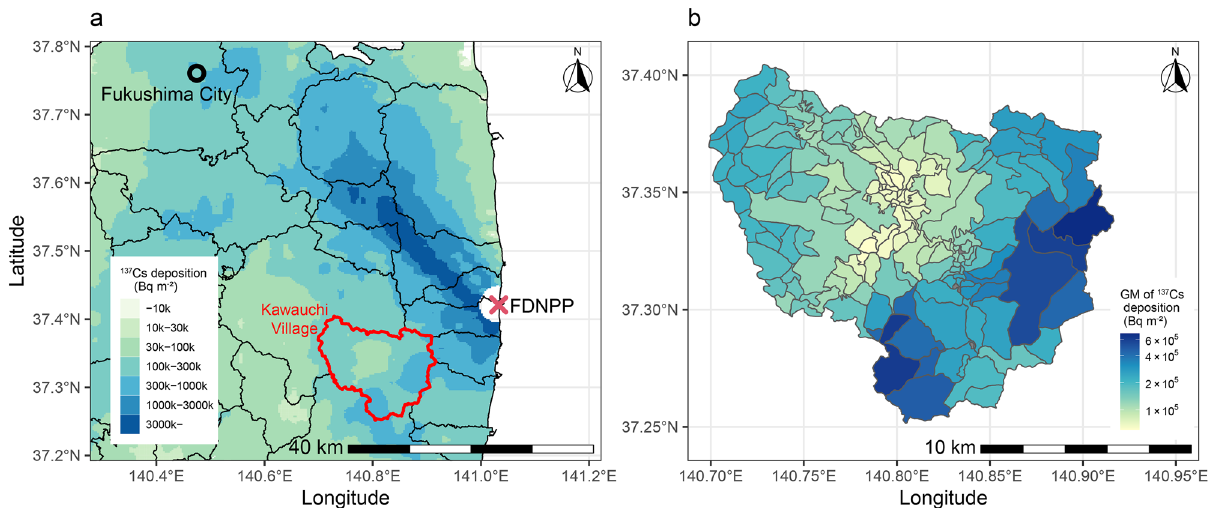
Figure 1. ( a ) Location of Kawauchi Village. 137 Cs deposition amount provided by Kato and Onda 26 is filled on the map. The municipal boundaries were generated from Administrative Zones Data 27 . ( b ) The sub-village (“Ko-aza”) boundaries of Kawauchi Village. The geometric mean (GM) of 137 Cs deposition by Kato and Onda 26 was shown for each sub-village. The sub-village boundaries were created from a hand-drawn map obtained from the administrative office. The 137 Cs deposition data in the plotted areas were based on the results of the third airborne monitoring survey performed by the Ministry of Education, Culture, Sports, Science and Technology (MEXT) from May 31 to 2 July 2011 28 . These maps were created using R version 4.1.0 29 and ggplot2 package 30